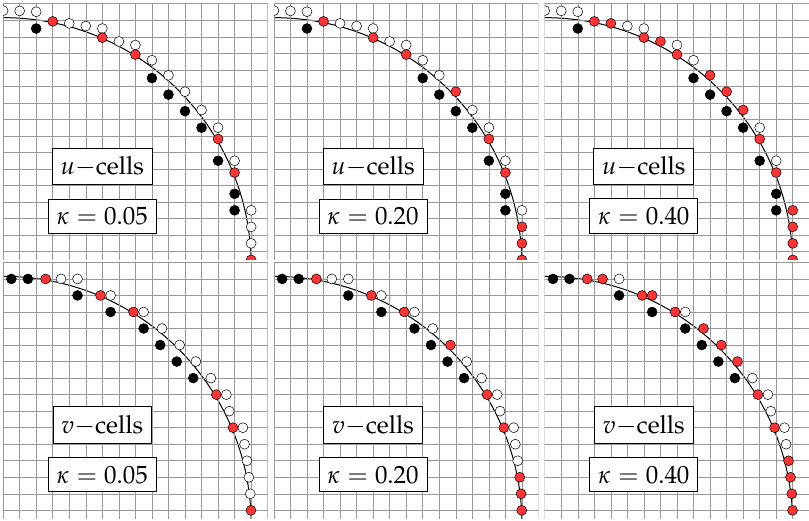
Figure 26. Fluid (white), solid (black) and slave (red) cells distribution around the immersed solid for the flow around a cylinder case with the E grid.